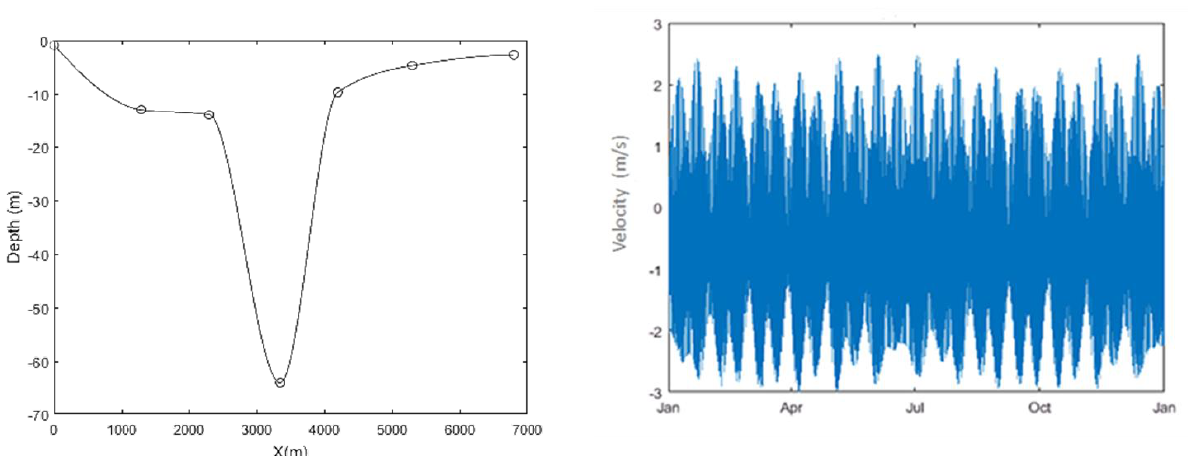
Fig. 5. Depth distribution (m) at the entrance of the San José Gulf as a function of the distance along this line 𝐴𝐵̅̅̅̅ in Fig. 4 (depths referred to the lower limit of the mean low neap tides, according to SHN [35] (last update 2015-06-24).